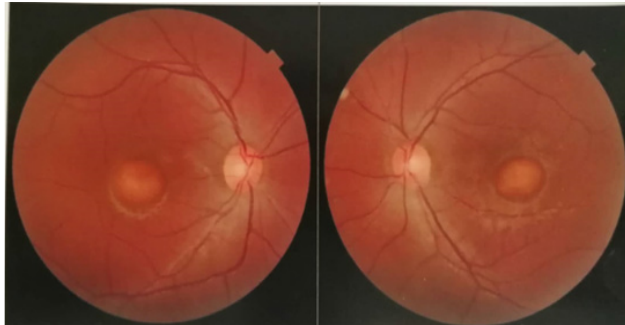
Figs 1a and 1b: Right and left fundus showing yellow or orange well-circumscribed dome shaped egg-yolk like sub-retinal lesion approximately disc diameter in size at macula.